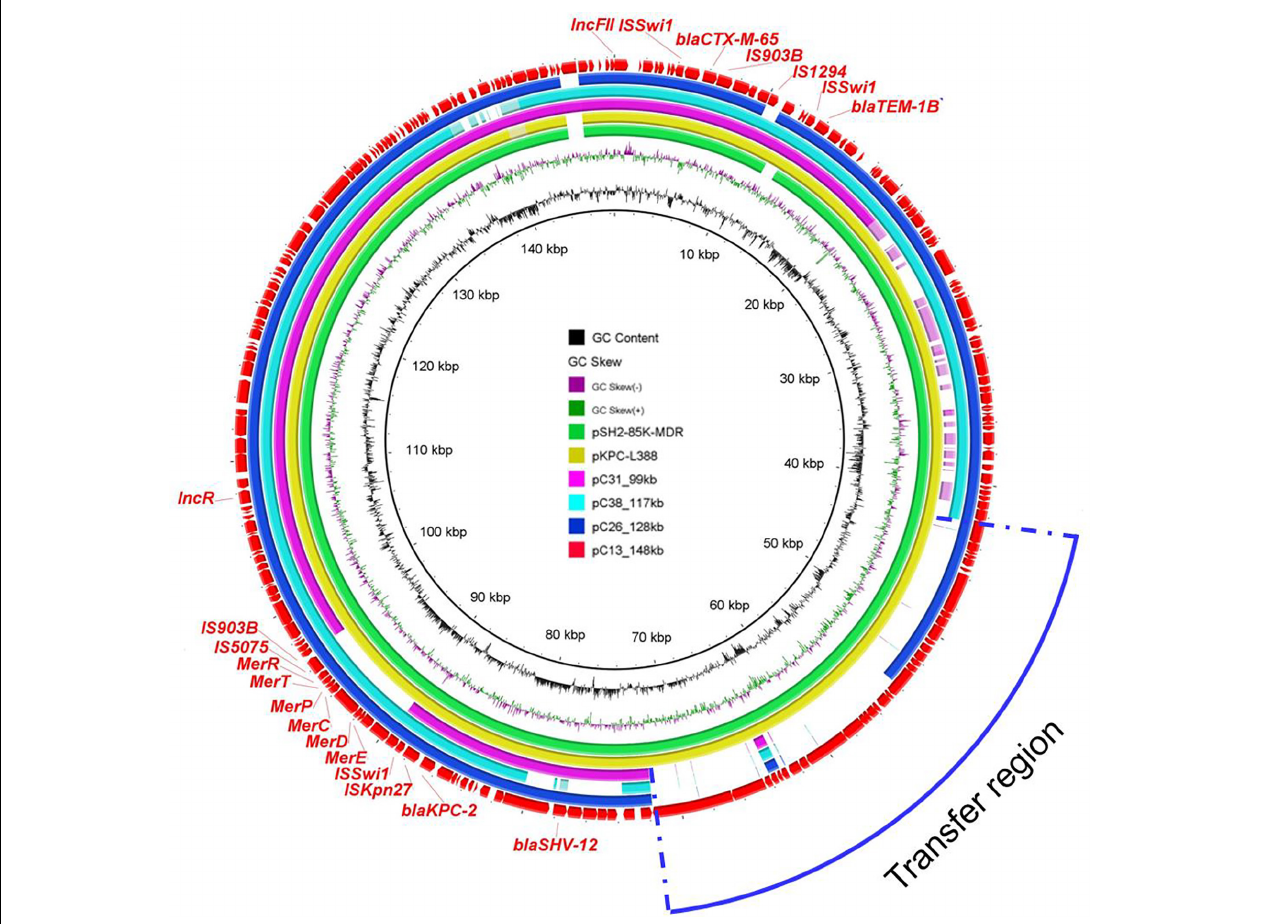
FIGURE 4 | Circular comparison between the four bla KPC − 2 -bearing plasmids in this study and other most similar plasmids in the NCBI nr database. The plasmid pC13_148 kb was used as the reference in the outmost